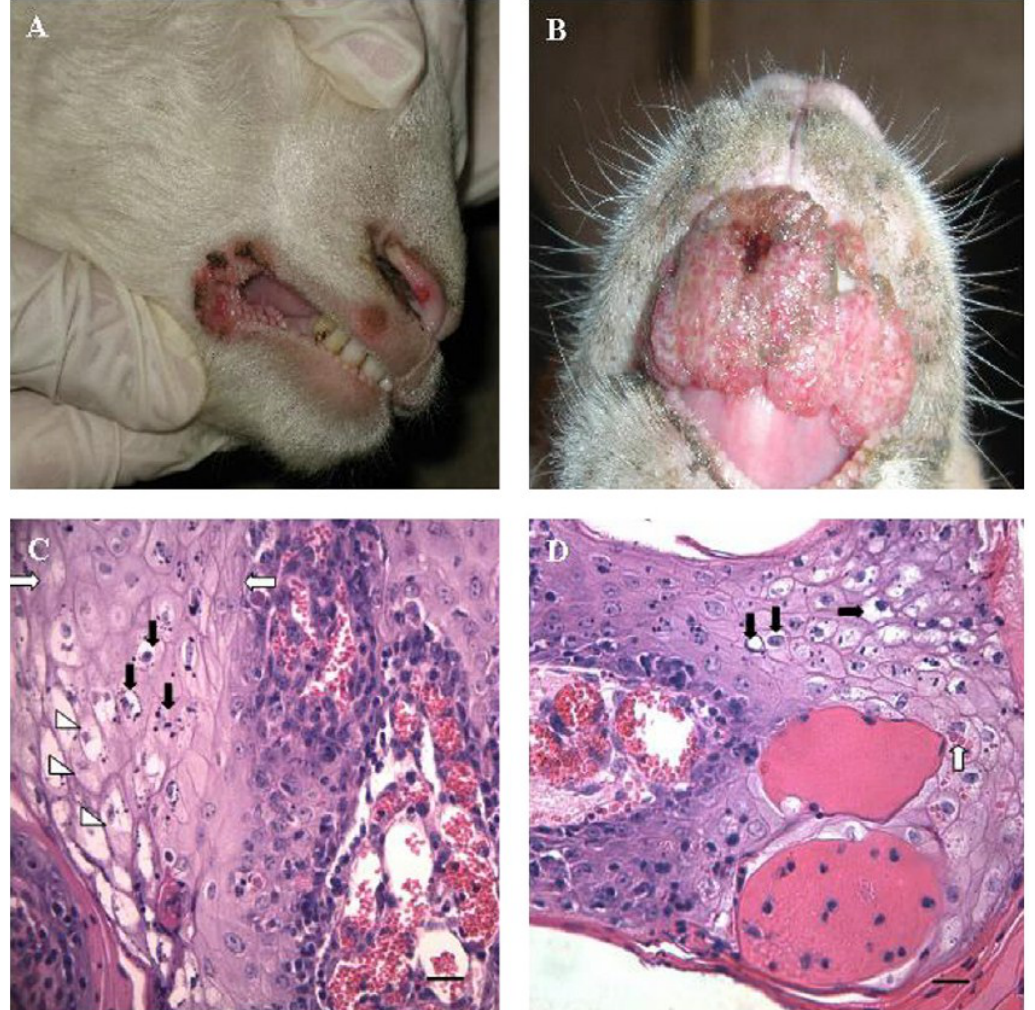
Figure 1. ( A ) Sheep showing multiple nodular lesions on the upper and lower labia and the junction of lips; ( B ) Sheep with severe proliferative orf lesions in the skin of lips and muzzle; ( C ) Spinous cells of the stratum spinosum showing acanthosis (white arrows), vacuolation (arrow heads) and karyorrhexis (black arrows). (H&E, 400×; bar = 100 µm); ( D ) Intraepithelial ballooning degeneration (black arrows) and intracytoplasmic eosinophilic inclusion bodies (white arrows) in the acanthocytes. (H&E, 400×; bar = 100 µm) (adapted from Zhao et al. [21] with permission from Elsevier